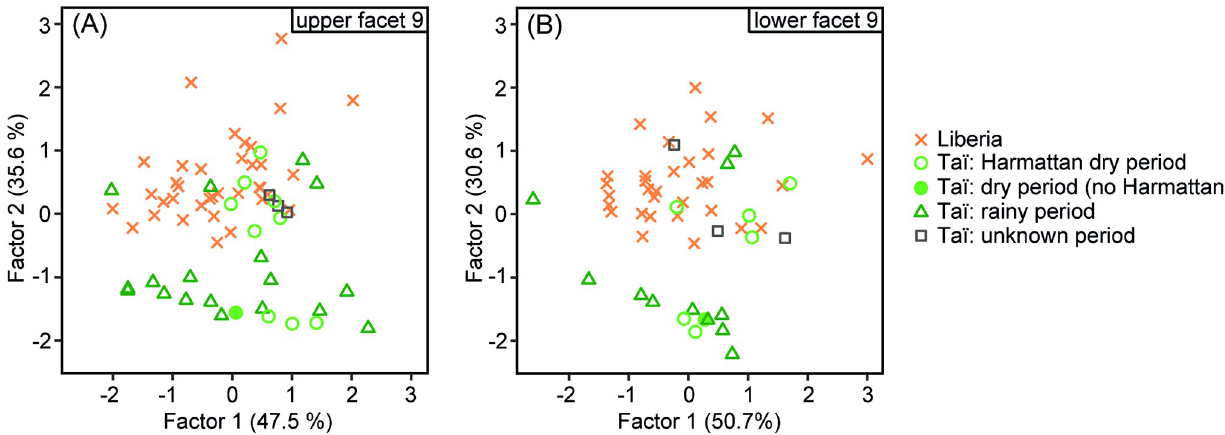
Fig 3. Factor analysis of wear facet 9 comparing the Liberian chimpanzee population to Ta ї chimpanzees from dry and rainy periods. (A) upper molars; (B) lower molars; 3DST data for Ta ї chimpanzees taken from Schulz-Kornas et al. [13].